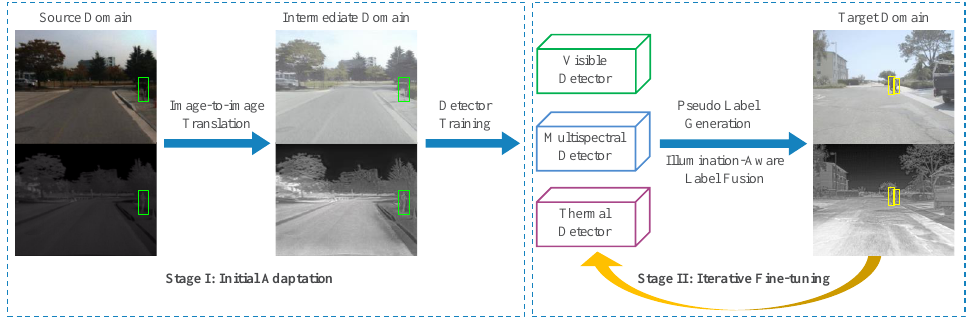
Figure 2. Illustration of the proposed scheme. The overall process consists of two stages: initial adaptation and iterative fine-tuning. The initial adaptation stage aims at handling the domain shift problem across the source and target domains. The iterative fine-tuning stage is adopted to converge the multispectral pedestrian detector on the target domain progressively, based on illumination-aware fused pseudo